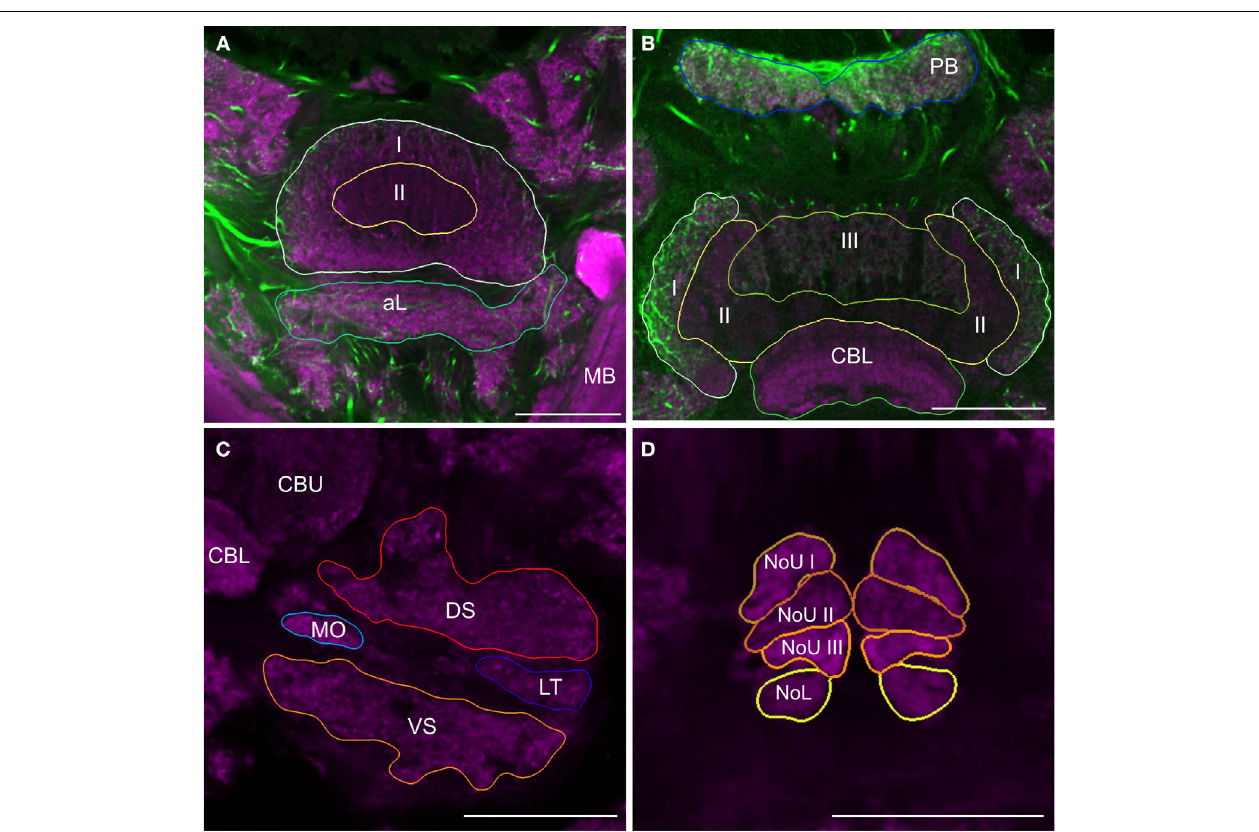
FIGURE 2 | Images from frontal sections through the central complex and lateral accessory lobe at different levels based on immunostaining for synapsin (magenta) and serotonin (green) . (A) Optical slice through layer I (I) and II (II) of the upper division of the central body and the anterior lip (aL) at the level of the mushroom bodies (MB). (B) Axial slice through the protocerebral bridge (PB), layer I (I), II (II) and III (III) of the upper division of the central body and the lower